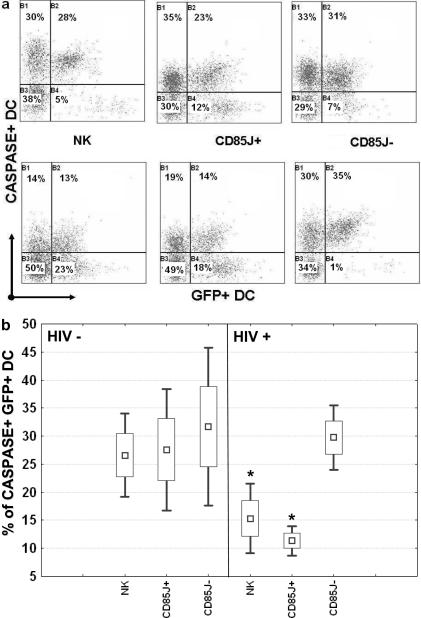
Decrease in CD85j+ NK cell cytotoxic activity against DC after co-culture with HIV-1-infected DC.(a) Cytolytic activity of total NK cells (NK), CD85j-enriched NK cells (CD85j+) and CD85j-depleted NK cells (CD85j−) derived from 5-day cocultures with uninfected MDDC (top panels) or HIV-1-infected MDDC (bottom panels) were analyzed for their lysis of HIV-1/GFP infected MDDC. Lysis of target MDDC replicating HIV (GFP+) and not replicating HIV (GFP-) are measured by caspase staining (quadrants B1 and B2, respectively). A representative experiment is shown. (b) Percentages of lysis of HIV-1/GFP+ MDDC target cells by total NK cells or by the CD85j+ or CD85j− subset coculture with uninfected MDDC (HIV-, left panel) or with HIV-1-infected MDDC (HIV+, right panel). Results of 4 independent experiments are summarized. Boxes and whisker plots show the percentiles and median distribution of caspase-stained MDDC. Significant differences between NK cells from cocultures with uninfected MDDC and NK cells from cocultures with HIV-1 Bal-infected MDDC are indicated, **p<0.01.